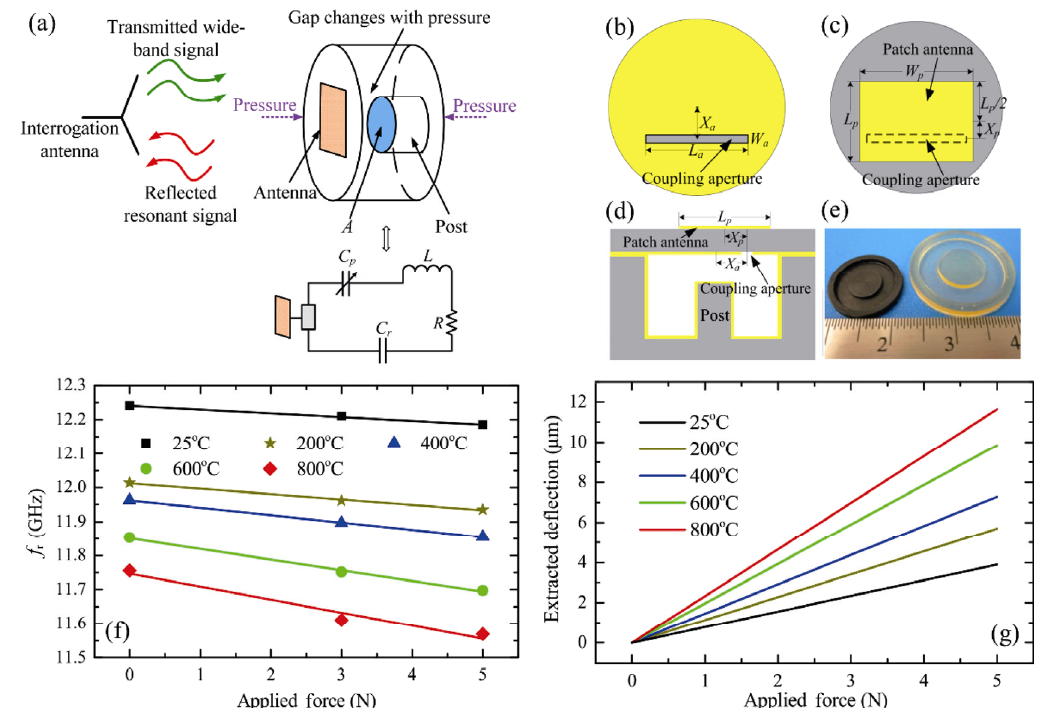
Fig. 16 (a) Schematic and circuit model of the proposed wireless pressure sensor based on an evanescent-mode cavity resonator; (b) and (c) are bottom and top views of the cap of the pressure sensor, respectively; (d) is the cut view of the patch antenna integrated pressure sensor; (e) are photographs of the polymer-derived ceramic cavity resonator before (right) and after pyrolysis (left); (f) measured resonant frequency of the polymer-derived pressure sensor as a function of the applied force at high temperatures; and (g) extracted deflection of the pressure sensor cap as a function of the applied force at high temperatures. Reproduced with permission from Ref. [368], © Elsevier B.V.